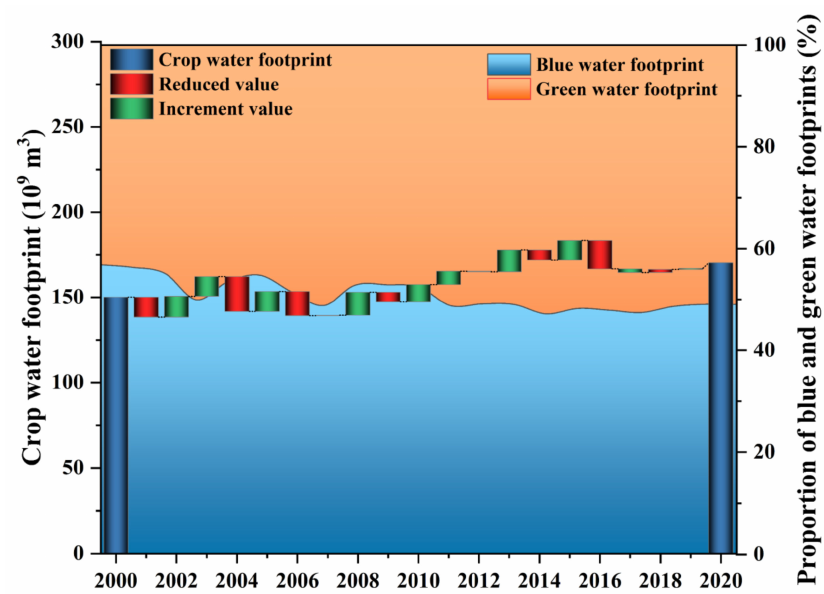
Figure 6. Evolution of crop water footprint over time in Northwest China from 2000 to 2020. Note: The left axis represents the crop water footprint, which corresponds to the bar graph. The red and green columns in the bar chart represent the decrease or increase, respectively, in the crop water footprint in that year compared to the previous year. The right axis represents the blue and green water footprint as a proportion of the total water footprint, which corresponds to the area